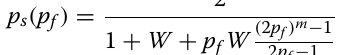
the schedule-driven duty-cycle node operation, including the processing and transmission of information